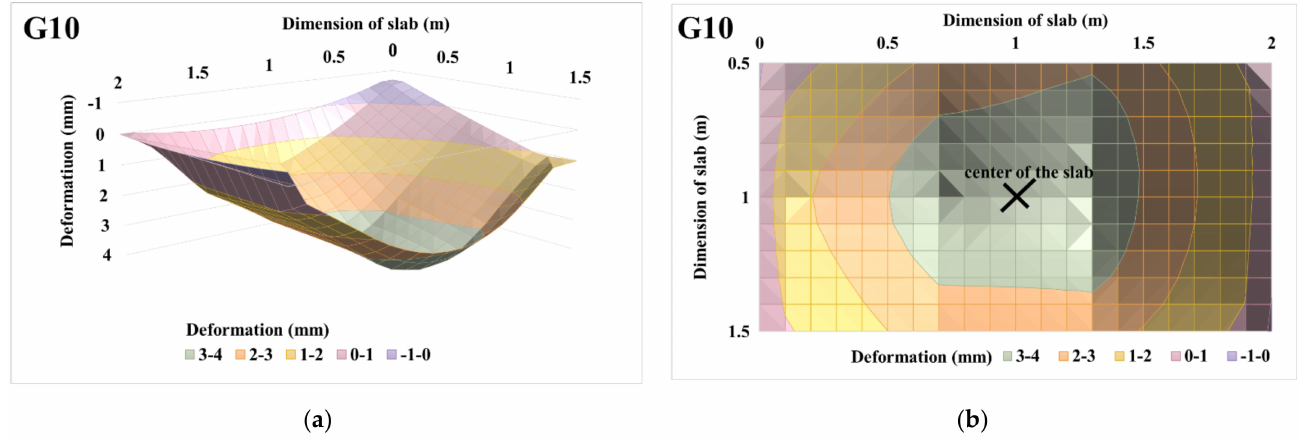
Figure 19. Centrically loaded slab G10 with 225 kN load: ( a ) 3D deformation surface of the slab; ( b ) projection of 3D deformation surface of the